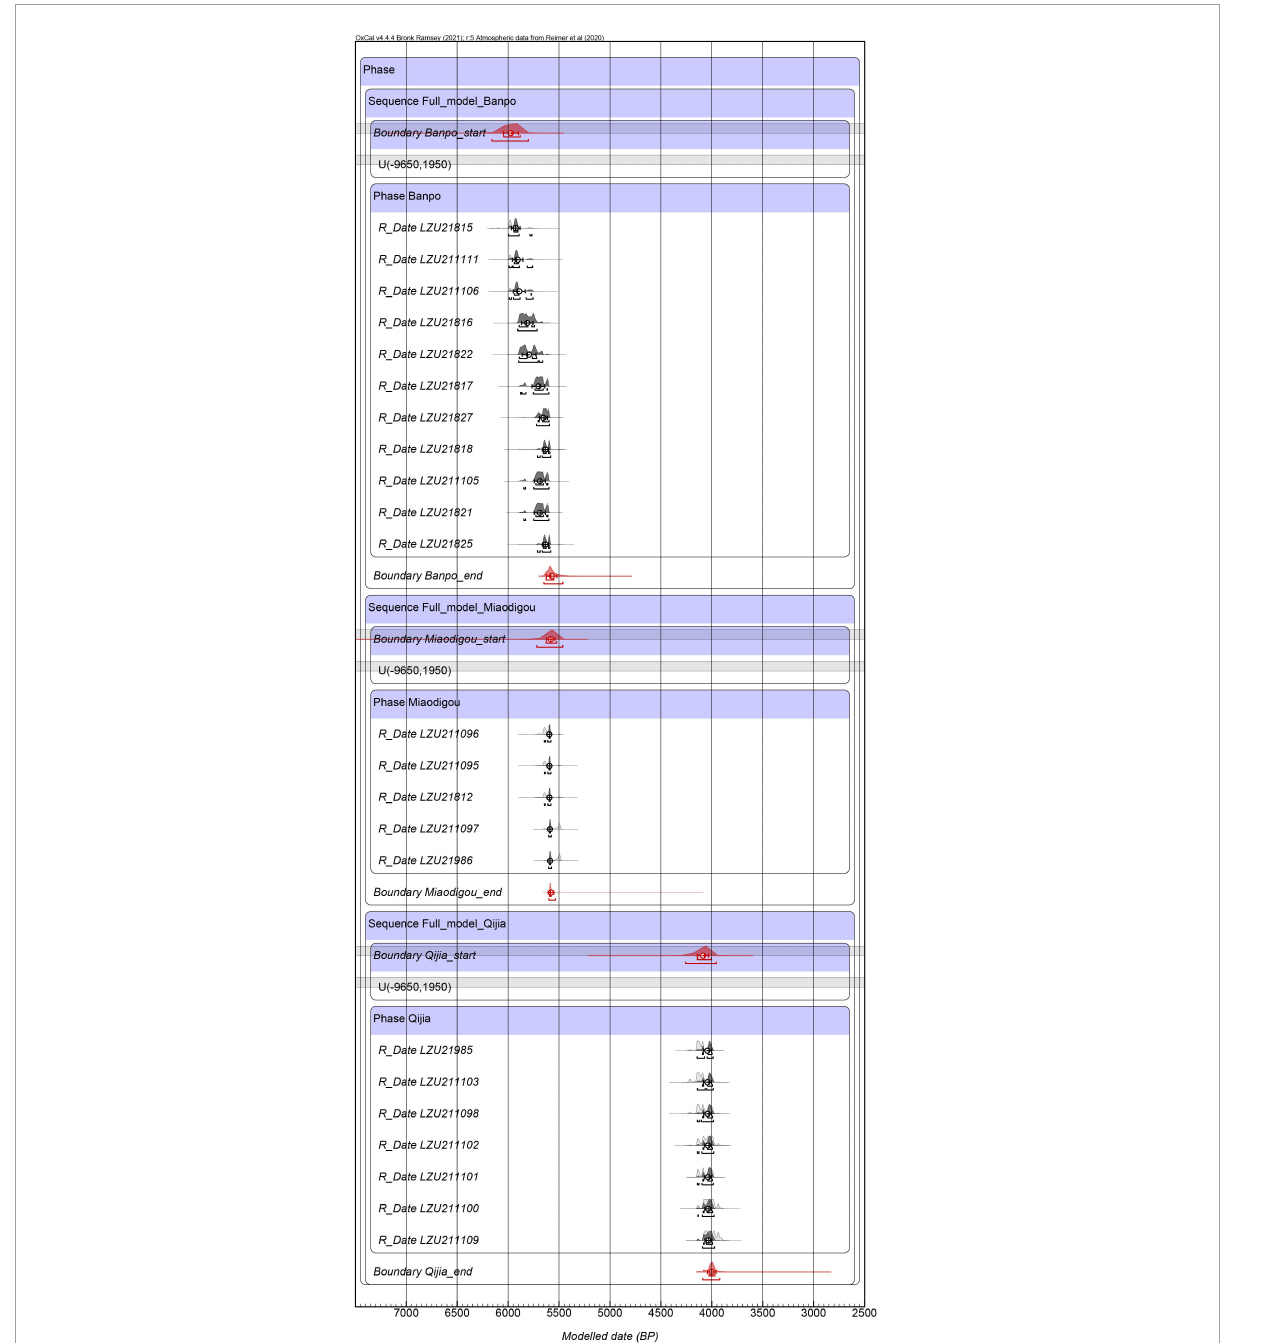
FIGURE4 The chronology of different prehistoric cultures based on the Bayesian model at the Gedachuan site.